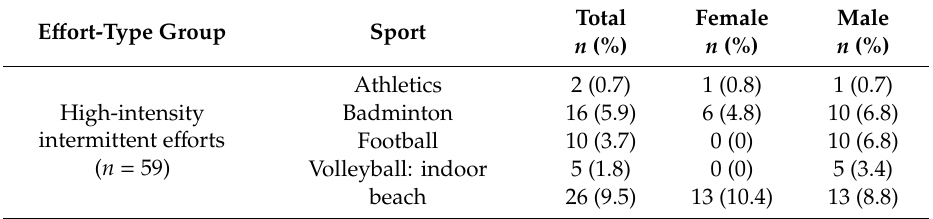
Table 1. Study population by type of e ff ort and sport disciplines. Data presented as number (%). E ff ort-Type